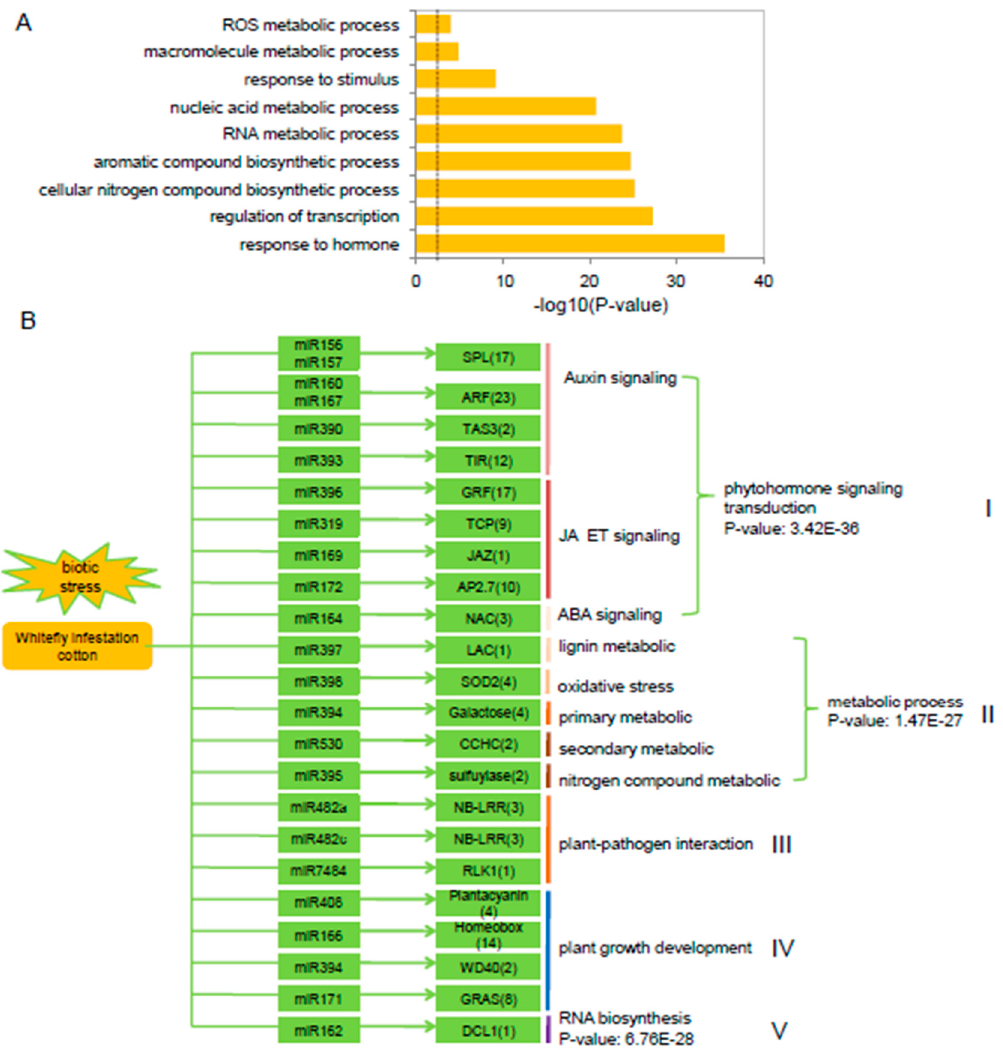
Figure 3. Validation of miRNA target genes based on degradome sequencing. ( A ) Gene ontology (GO) enrichment analysis of miRNA targets in cotton plants following whitefly infestation. The dashed line represents p < 0.01. ( B ) Overview of 24 conserved miRNA families, their corresponding targets and potentially associated pathways in cotton plants in response to whitefly infestation. p -values indicate the GO enrichment significant differences.